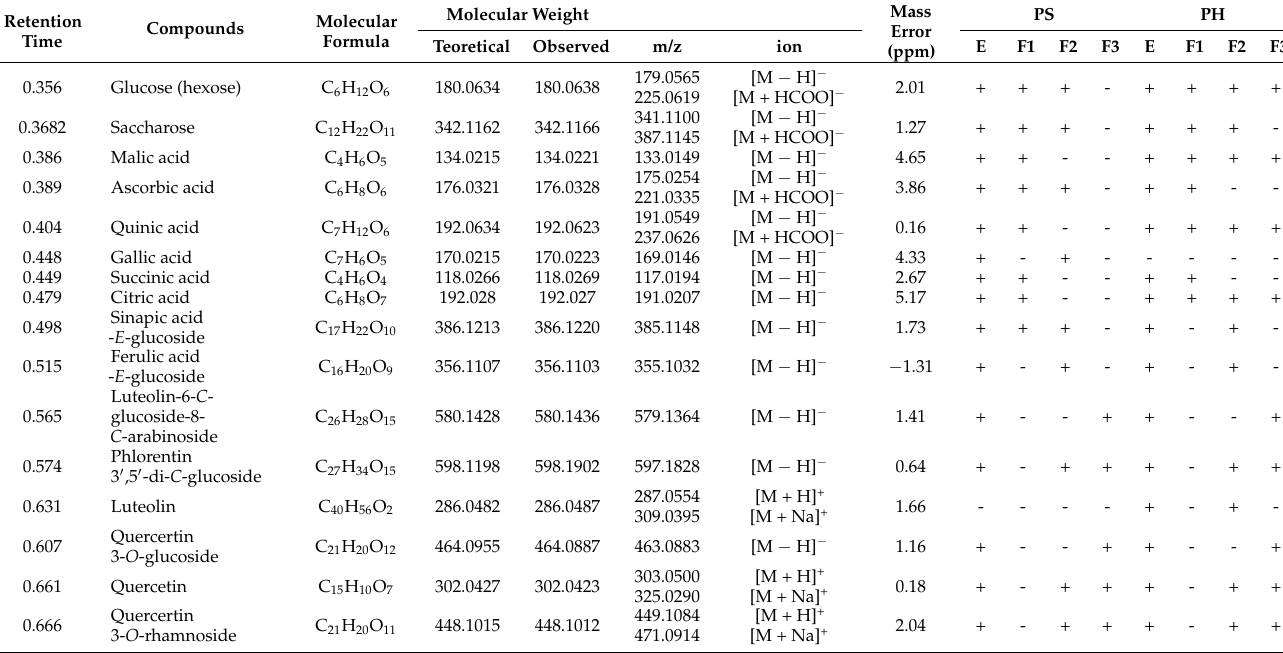
Table 3. Compounds identified in sweet and hot pepper fruit extracts by UPLC-ESI-QTOF. Retention Time